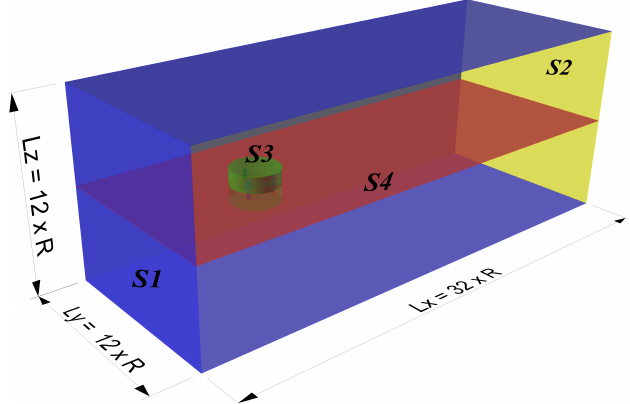
Figure 8. Three-dimensional computational domain.